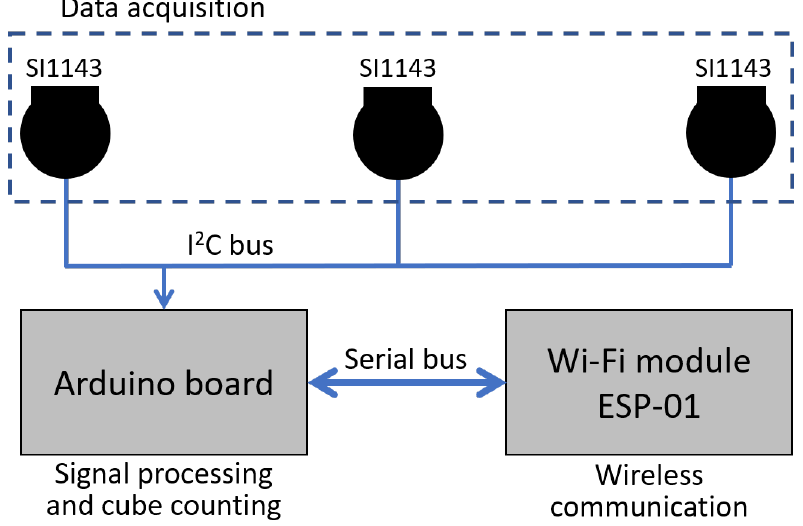
Figure 4. Architecture of the sensorized